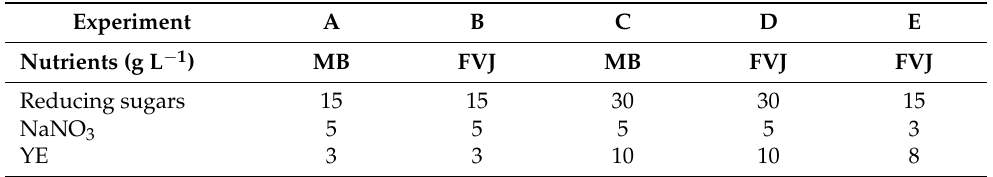
Table 2. Nutrient composition in bottle fed-batch trials in modified Bristol and fruit and vegetable juices